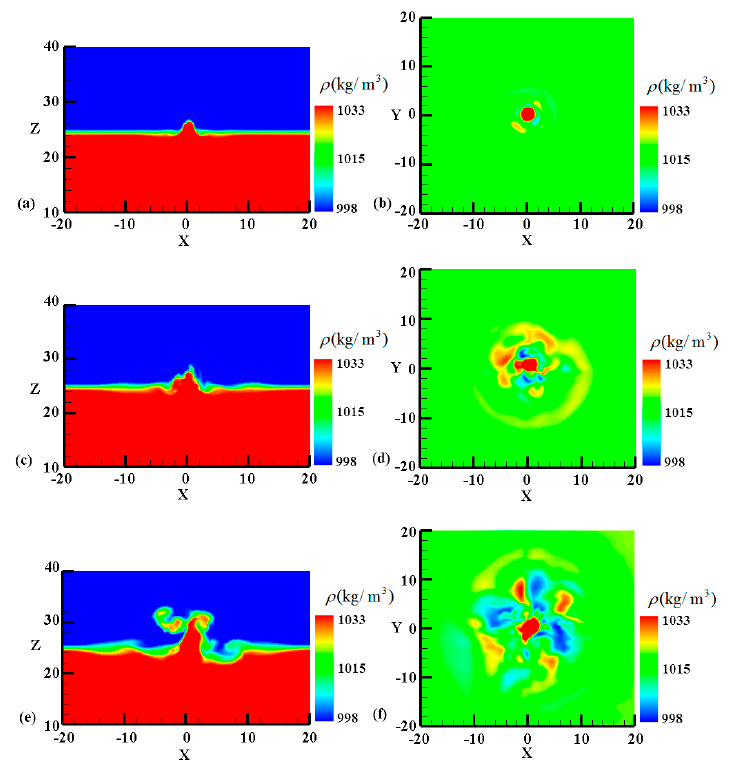
Figure 14. Instantaneous density contours at planes of Y = 0 (left) and Z = 25 (right) when T = 0.6. And ( a , b ) are the case A1; ( c , d ) are the case A3; ( e , f ) are the case A9.